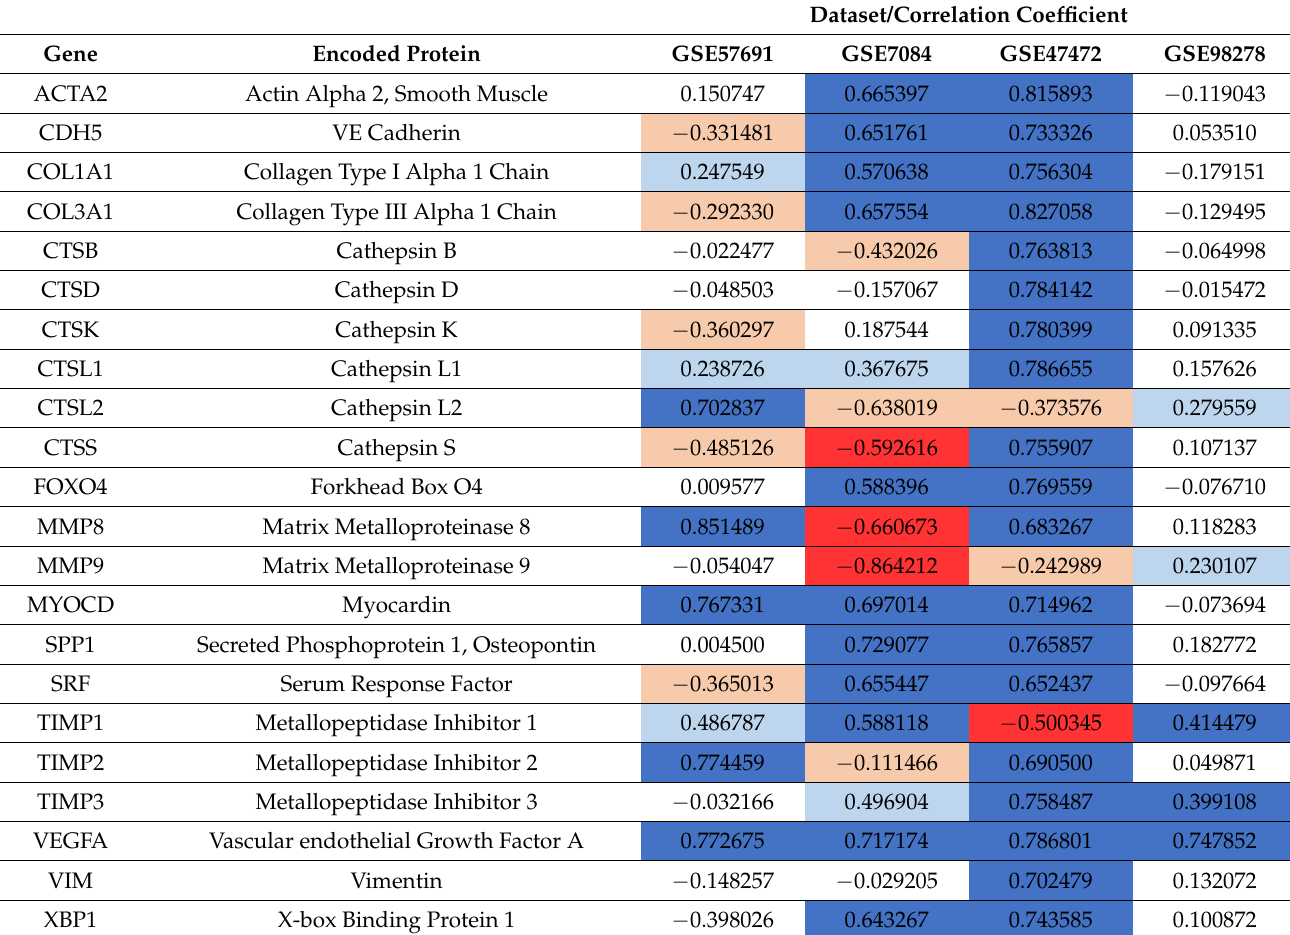
Dataset/Correlation